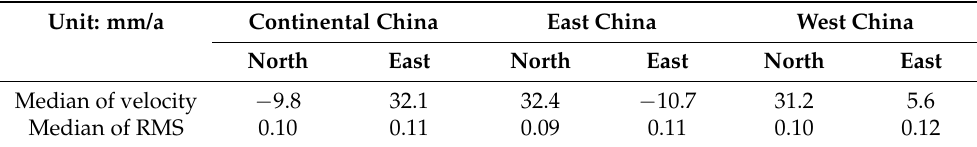
Table 1. The comparison of the horizontal velocity field in continental China. Unit: